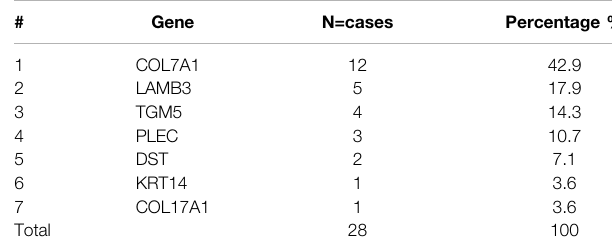
TABLE 1 | Frequency of the genes involved in all EB